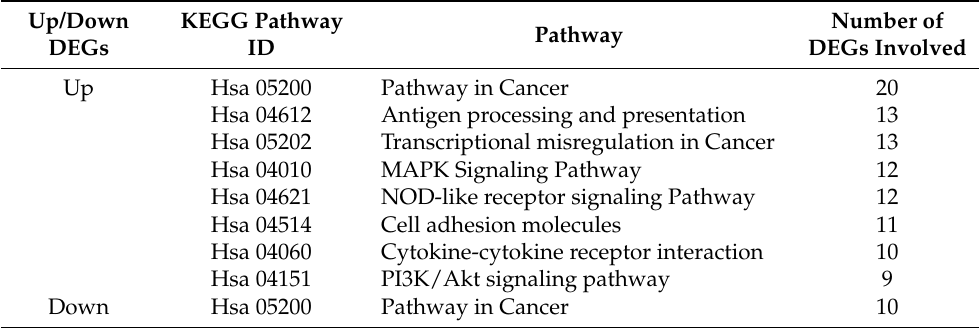
Table 2. A table of significantly enriched pathways. Pathways with more than 10 DEGs were considered as significantly enriched pathways. A list of significantly enriched pathways from up- and downregulated DEGs are presented with KEGG pathway ID and numbers of DEGs involved in each